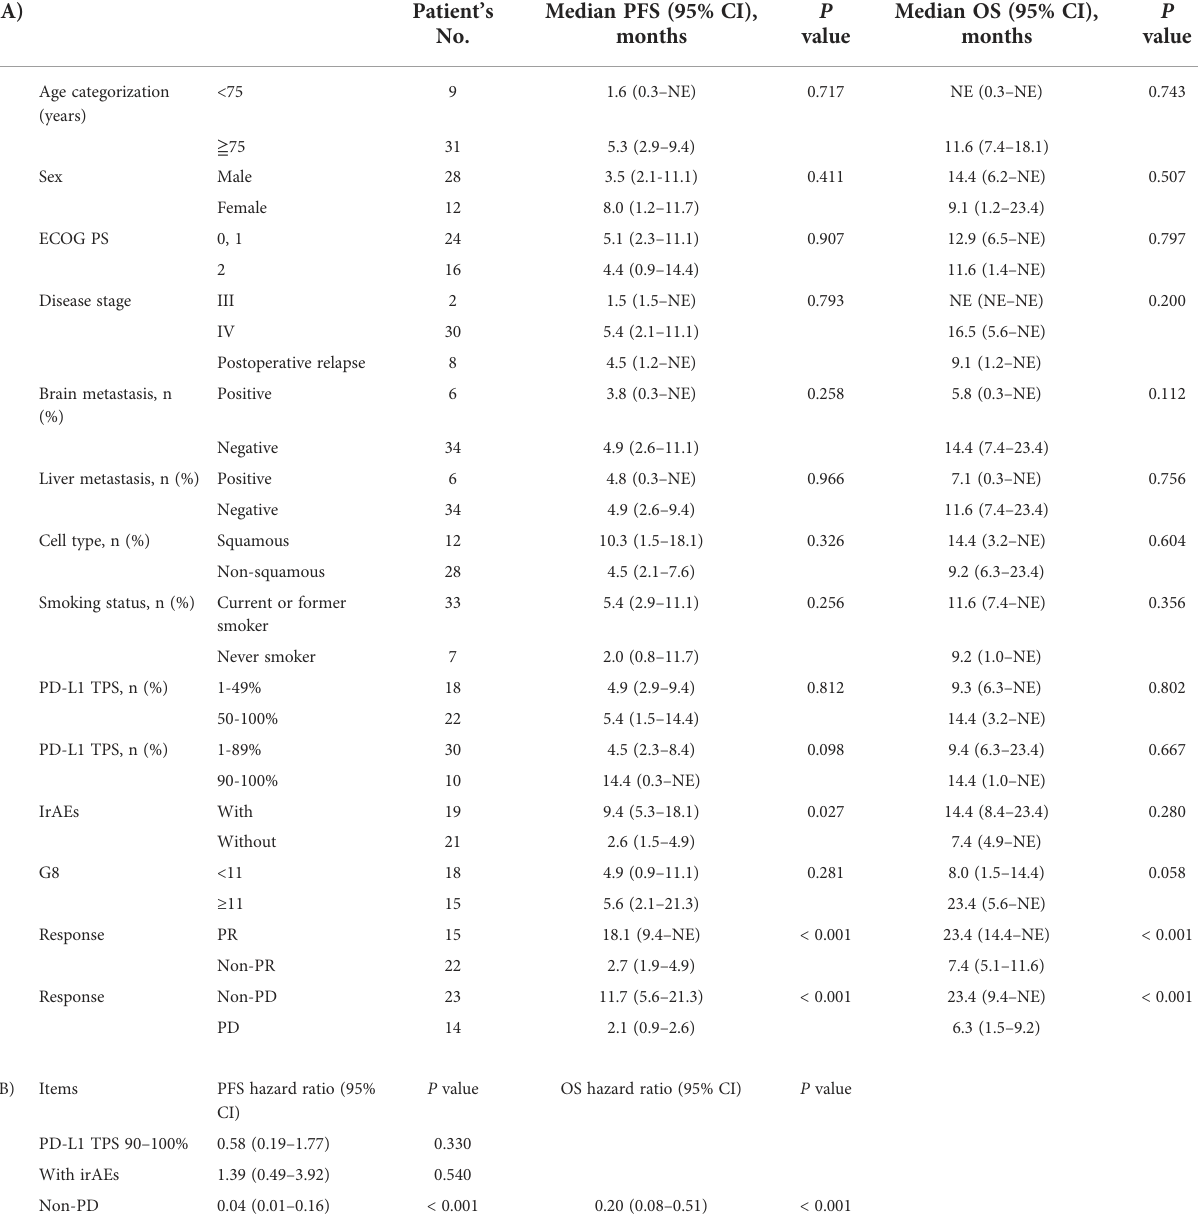
PFS,progression-free survival; OS,overallsurvival;CI, con fi dentialinterval; NE,notevaluable; ECOGPS,Eastern CooperativeOncologyGroups PerformanceStatus; PD-L1, programmed death-ligand 1; TPS, total proportion score; irAEs, immune-related adverse events; G8, geriatric 8; PR, partial response; PD, progression